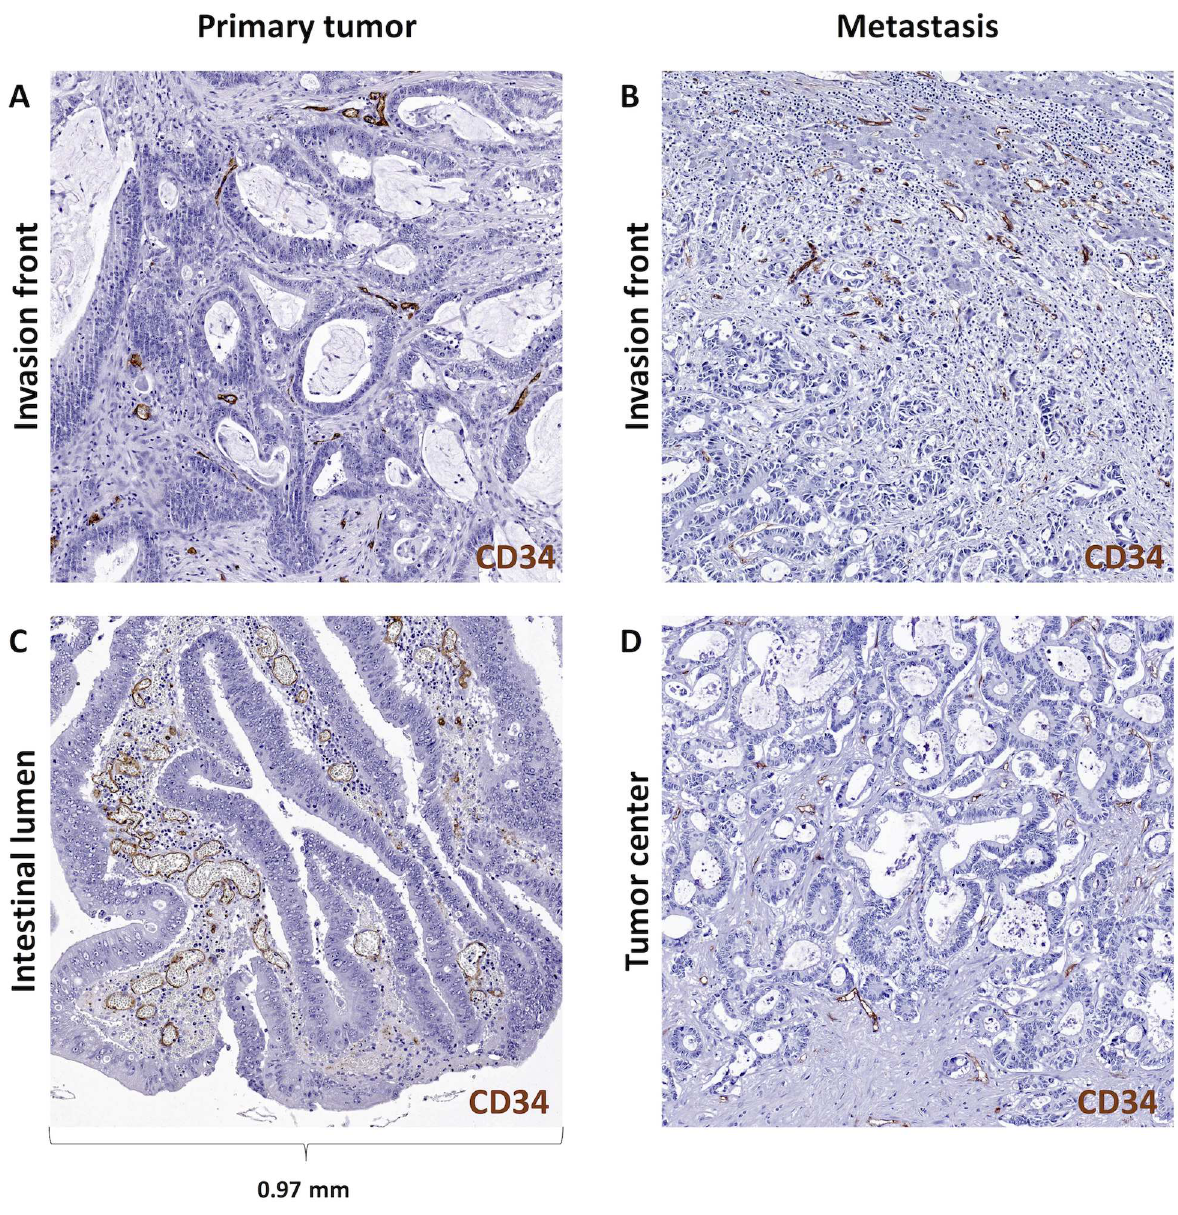
Fig 4. Histological aspect of the vascularbelt zone in CRC tissue. CRC primary tumor sample stainedfor CD34 (brown), (A) primary tumor near the invasionfront containsfew blood vessels, (B) liver metastasis near the invasionfront containsmany small bloodvessels, (C) primary tumor at the intestinallumen containsmany dilated blood vessels, (D) liver metastasis tumor center containsfew blood